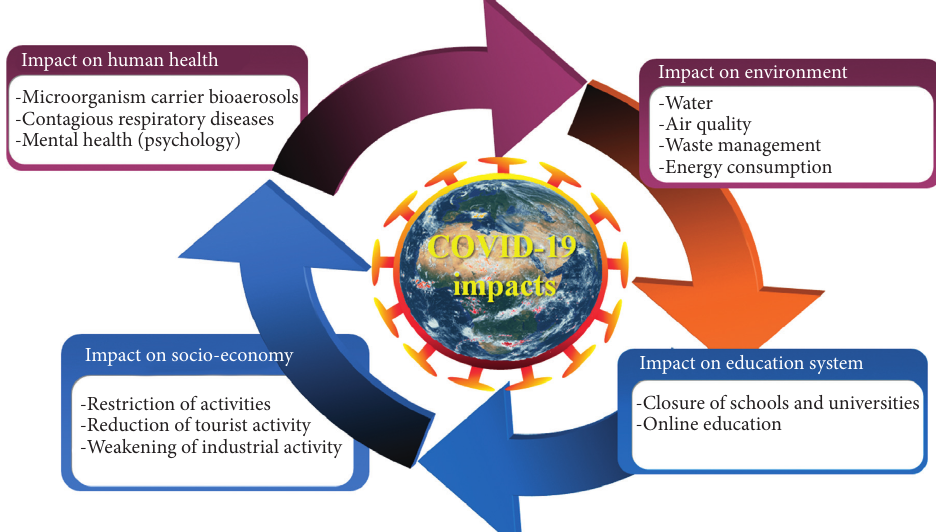
Figure 1: COVID-19 impacts on human health, environment, education system, and